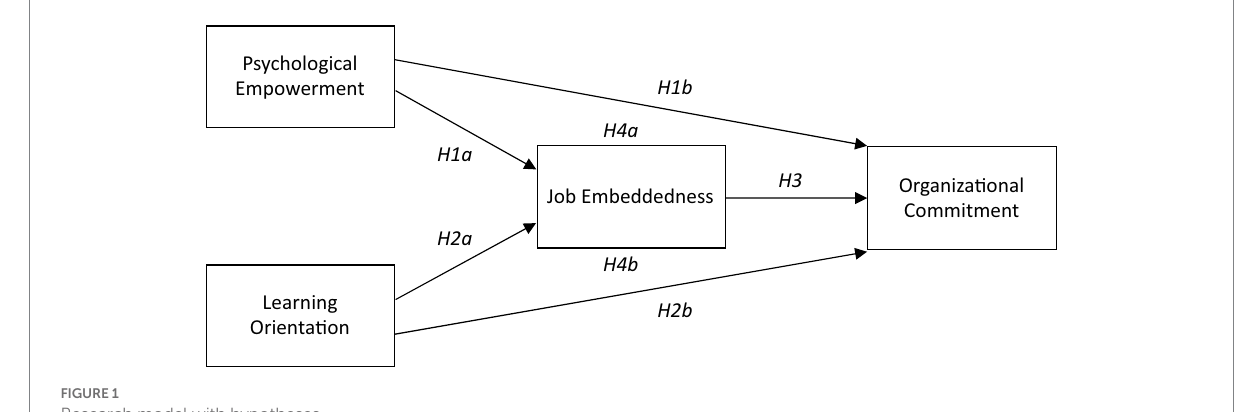
FIGURE 1 Research model with hypotheses.